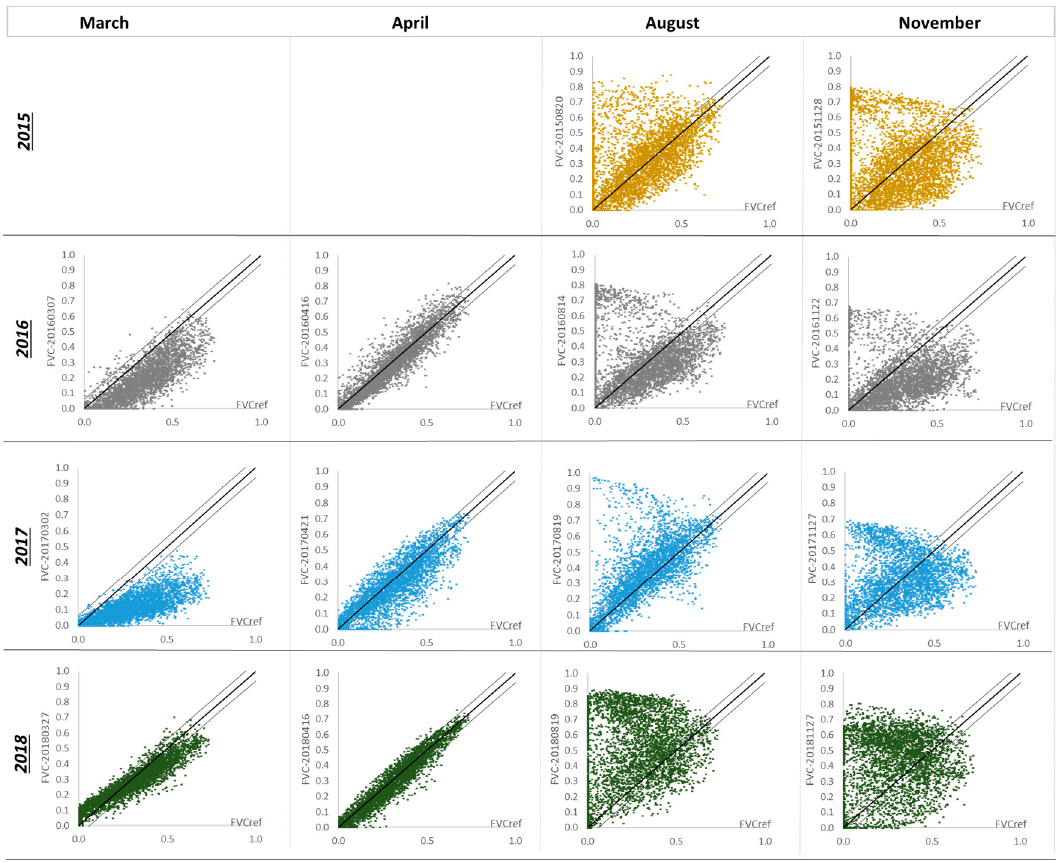
Figure 8. Inter-annual comparison (2015–2018) of fractional vegetation cover (FVC) compared to FVC of the reference image (FVCref) in March, April, August, and November of each